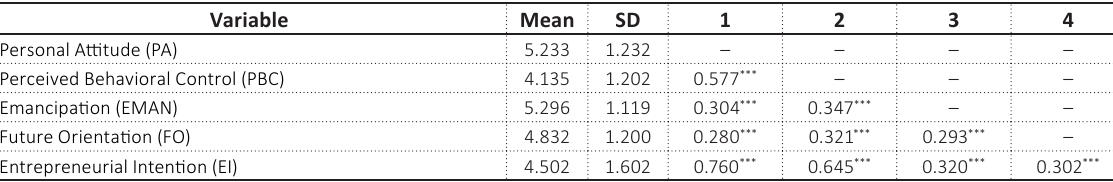
Table 2. Means, standard deviations, and intercorrelations among variables